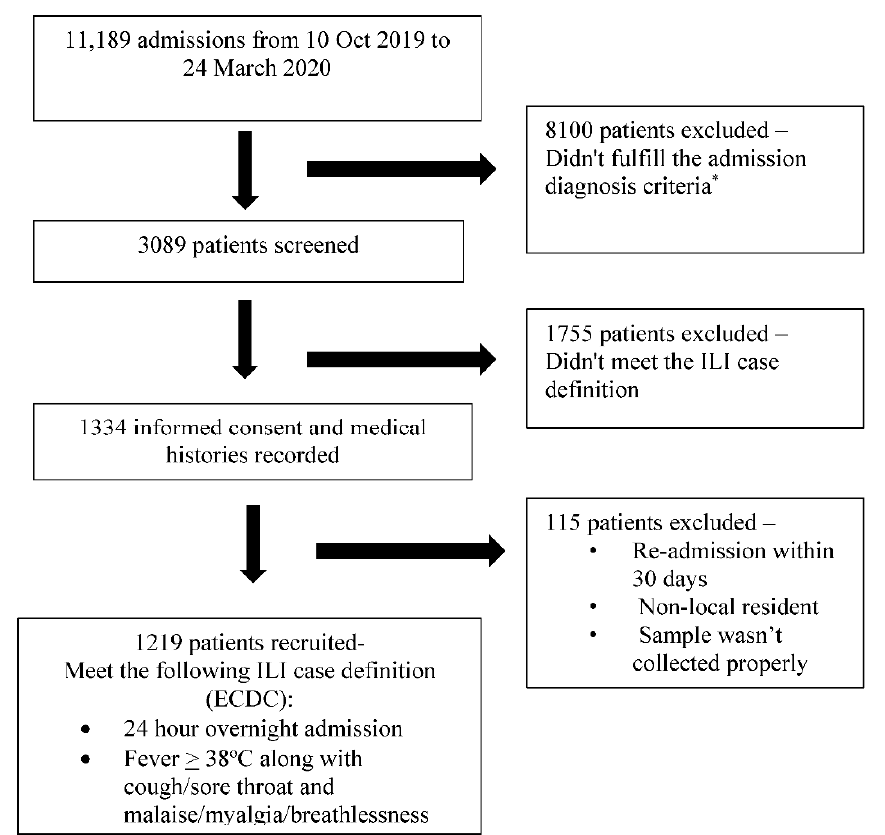
Figure 1. The selection of the patients for the study. The * admission diagnostic criteria as per the GIHSN format, included the following: For those aged 5 years old or more: acute upper or lower respiratory disease, acute myocardial infarction or acute coronary syndrome, acute asthma or exacerbation, acute heart failure, pneumonia and influenza, bronchitis and exacerbations of chronic pulmonary obstructive disease, acute respiratory failure, acute metabolic failure (diabetic coma, renal dysfunction, acid–base disturbances, alterations to the water balance), altered consciousness, convulsions, febrile convulsions, syncope and collapse, dyspnea, respiratory abnormality, shortness of breath, respiratory abnormality (not otherwise specified), respiratory symptoms/chest symptoms, fever or fever of unknown origin or non-specified cough, sepsis, systemic inflammatory response syndrome. For less than 5 years: acute upper or lower respiratory disease, dyspnea, breathing anomaly, shortness of breath, tachypnoea (polypnea), acute asthma or exacerbation, pneumonia and influenza, acute respiratory failure, acute heart failure, altered consciousness, convulsions, febrile convulsions, fever or fever of unknown origin or non-specified, cough, gastrointestinal manifestations, sepsis, systemic inflammatory response syndrome (not otherwise specified), nausea and vomiting.